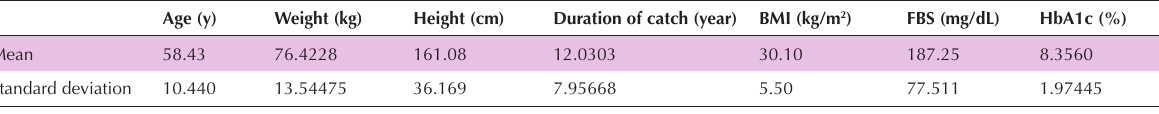
Table 1. Demographic